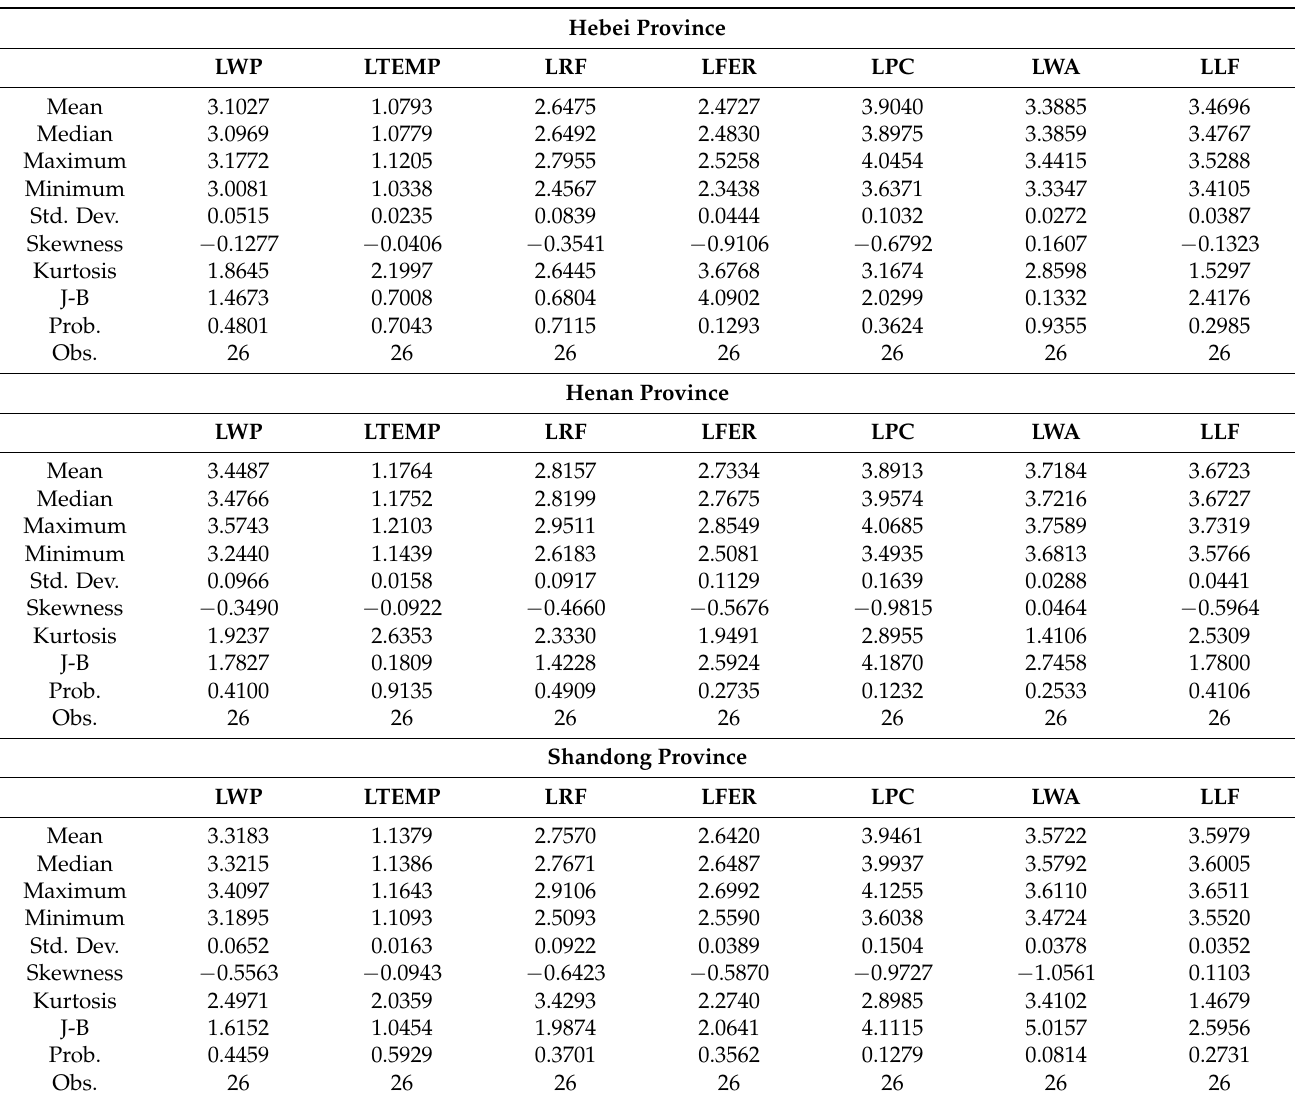
Table 1. Statistical summary for Hebei, Henan, and Shandong Provinces.